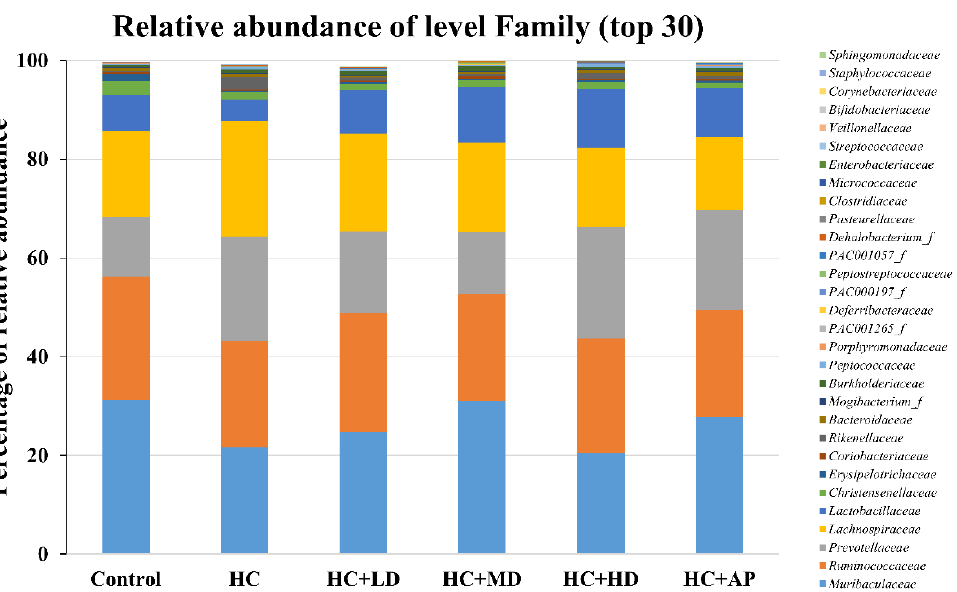
Figure 5. Effect of TCI227 on fecal microbiota family-level compositions in PO-induced hyperuricemia rats. The reported values are means (n = 3).